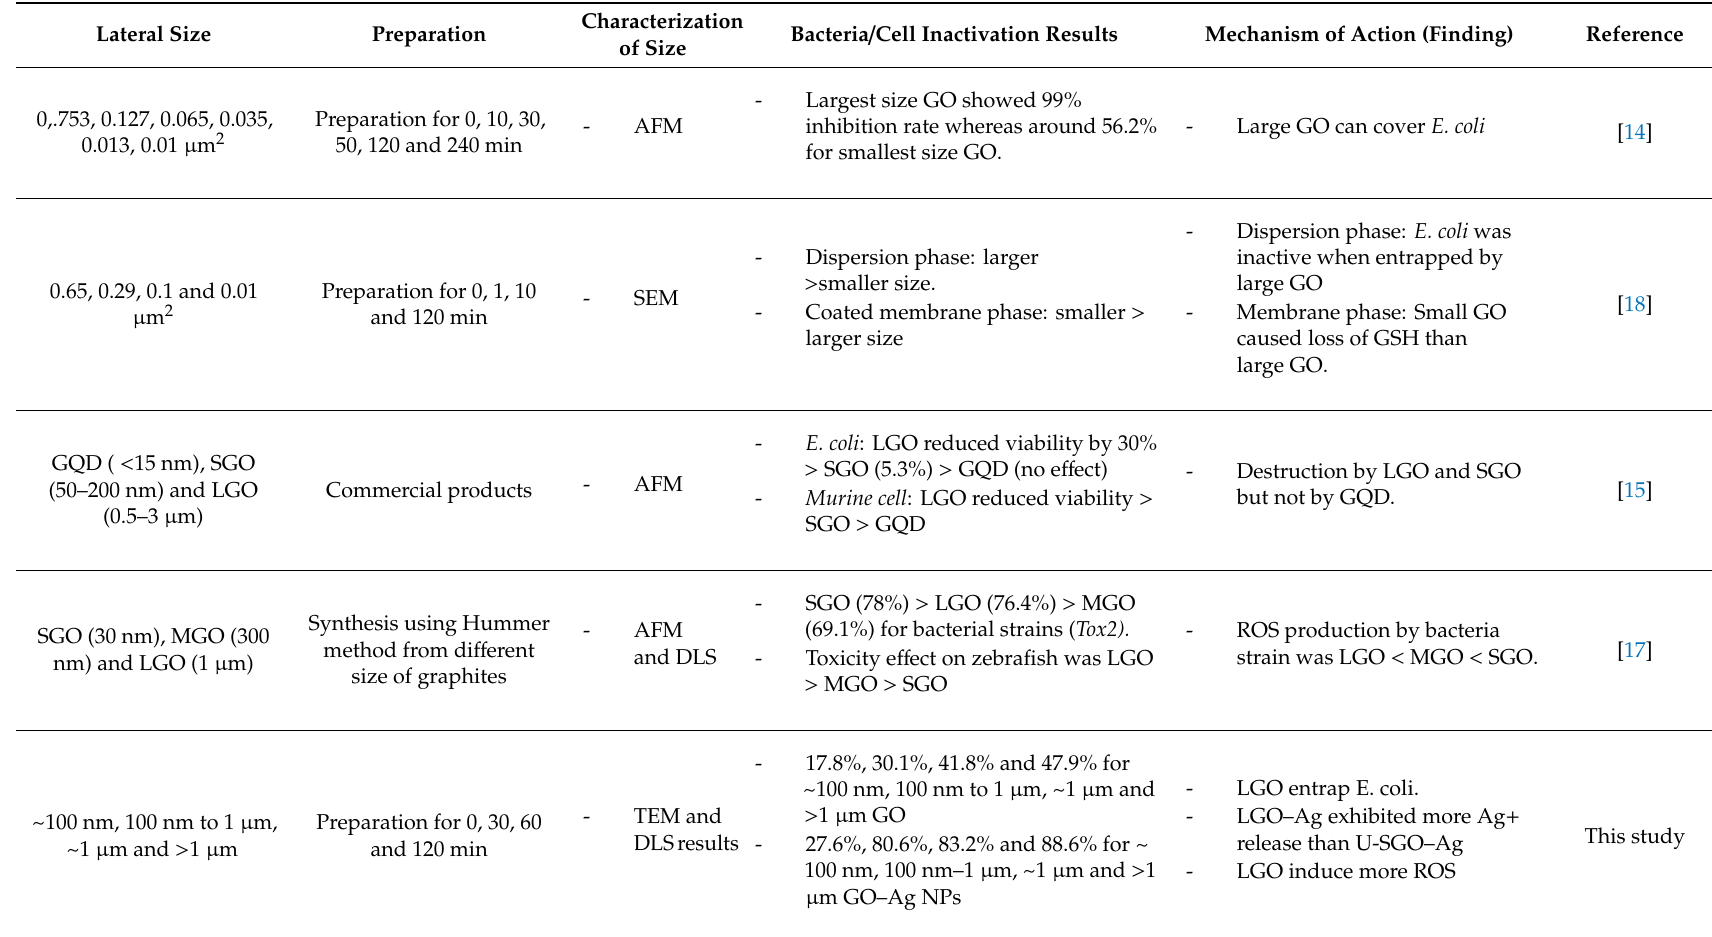
Table 2. A summary of GO’s various size-dependent antibacterial e ff